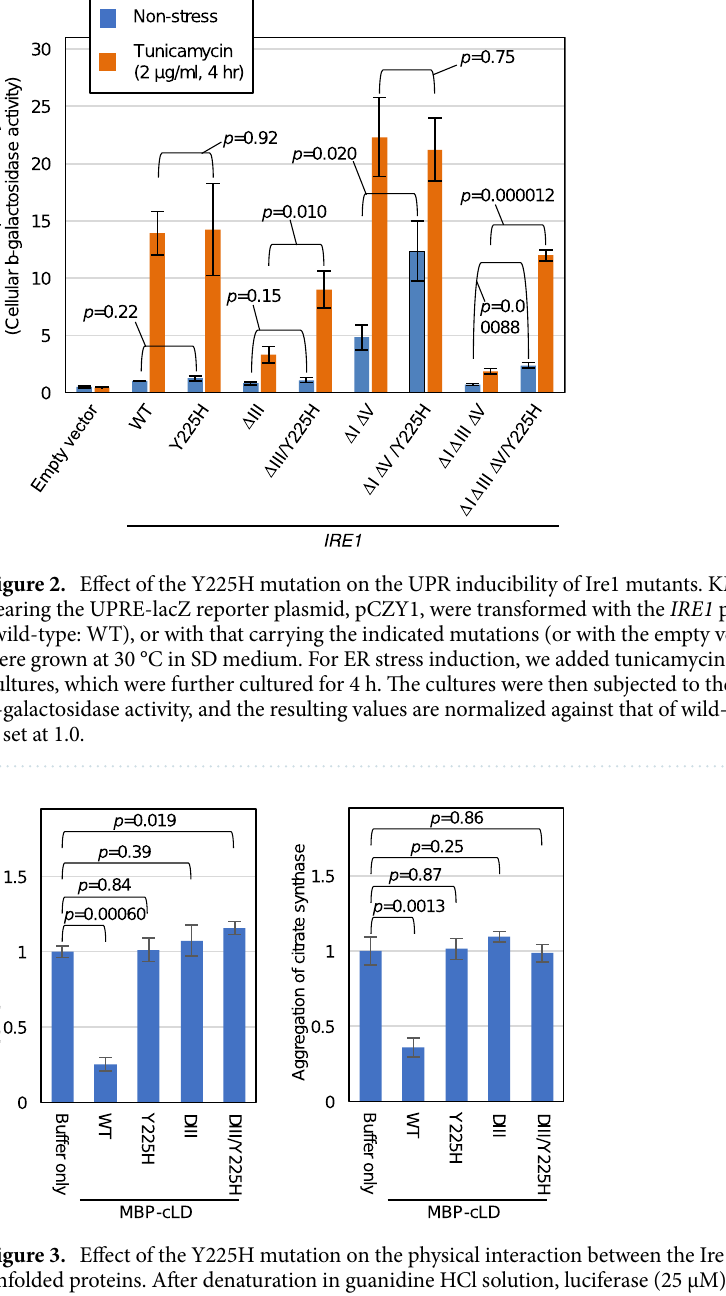
tary Fig. S1 for its position), the HAC1 -mRNA splicing of cells expressing ΔIΔIIIΔV/Y225H/V535R Ire1 was